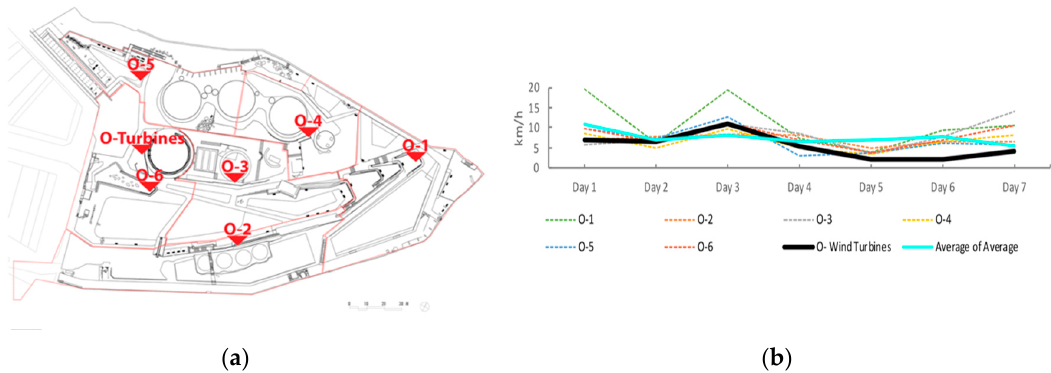
Figure 4. ( a ) BPP location map showing observation spots; ( b ) graph showing the daily averaged wind values for each spot.